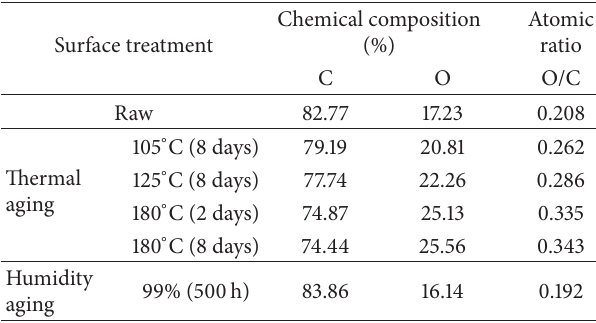
Table 5: Chemical composition of the polyketone/NR composite as thermal aging and humidity